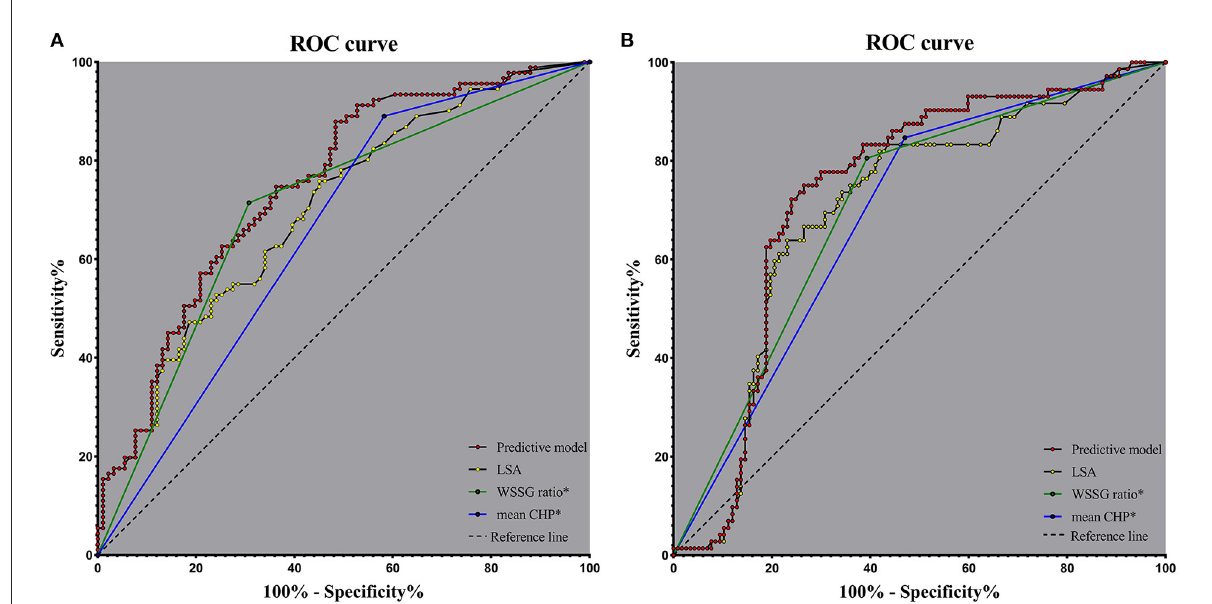
FIGURE5 Receiver operating characteristics curve analysis in the model cohort (A) and validation cohort (B) ; The predictive model based on the LSA, mean CHP ( > 0.087), and WSSG ratio ( > 893.180). mean CHP*: mean CHP ( > 0.087), WSSG ratio*: WSSG ratio ( > 893.180); CHP, combined hemodynamic parameter; WSSG, wall shear stress gradient; LSA, low shear